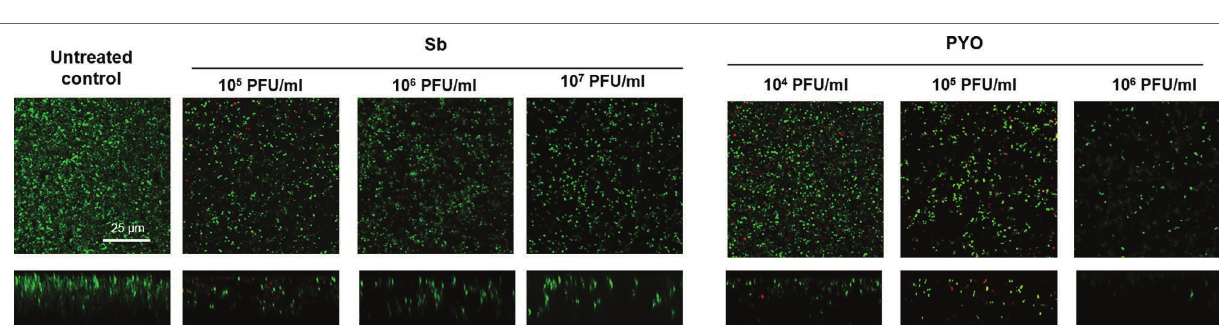
FIGURE 3 | CLSM images of MRSA ATCC 43300 biofilm treated with/without phages. MRSA biofilm (24 h-old) was exposed for further 24 h to different phage titers (10 4 –10 7 PFU/ml). The viability of the cells was evaluated staining biofilm with SYTO9 (488/500–540 nm – green) for alive bacteria and with propidium iodide (PI) (561/600–650 nm – red) for dead bacteria. Images are merged from the two channels. Upper and lower panels represent xy- and z-plans, respectively. Scale bar: 25 μ